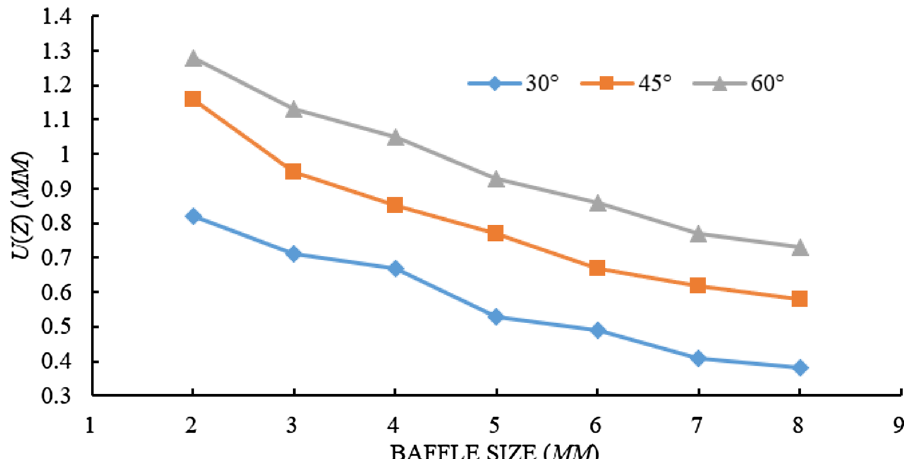
Fig. 8 Inclination angles vs z-direction displacements